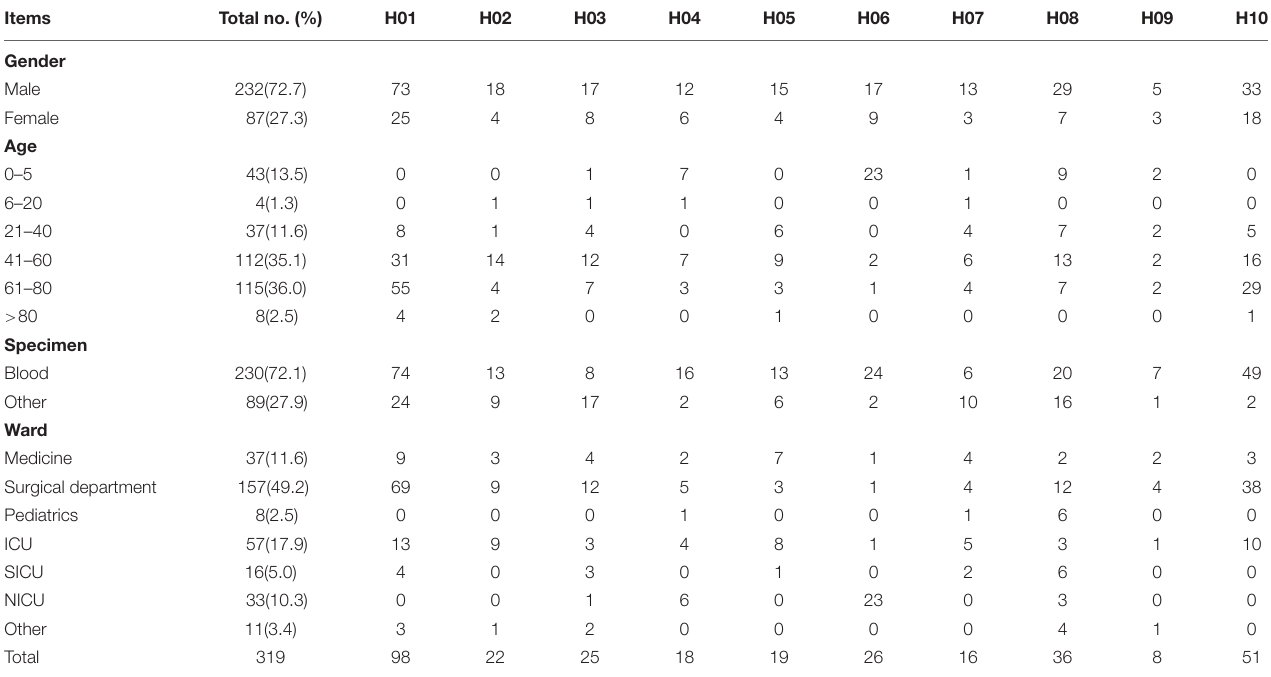
TABLE 1 | Clinical characteristics of 319 patients with invasive C. parapsilosis